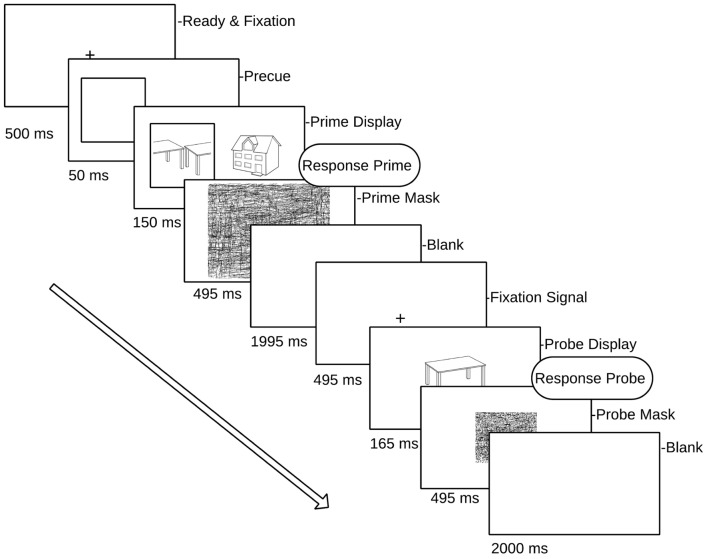
Schematic overview of a single prime–probe trial pair. Prime (attended) targets are displayed in a square (pre-cued) randomly to left or right of fixation cross. Participants responded to each (attended) prime and the subsequent probe.